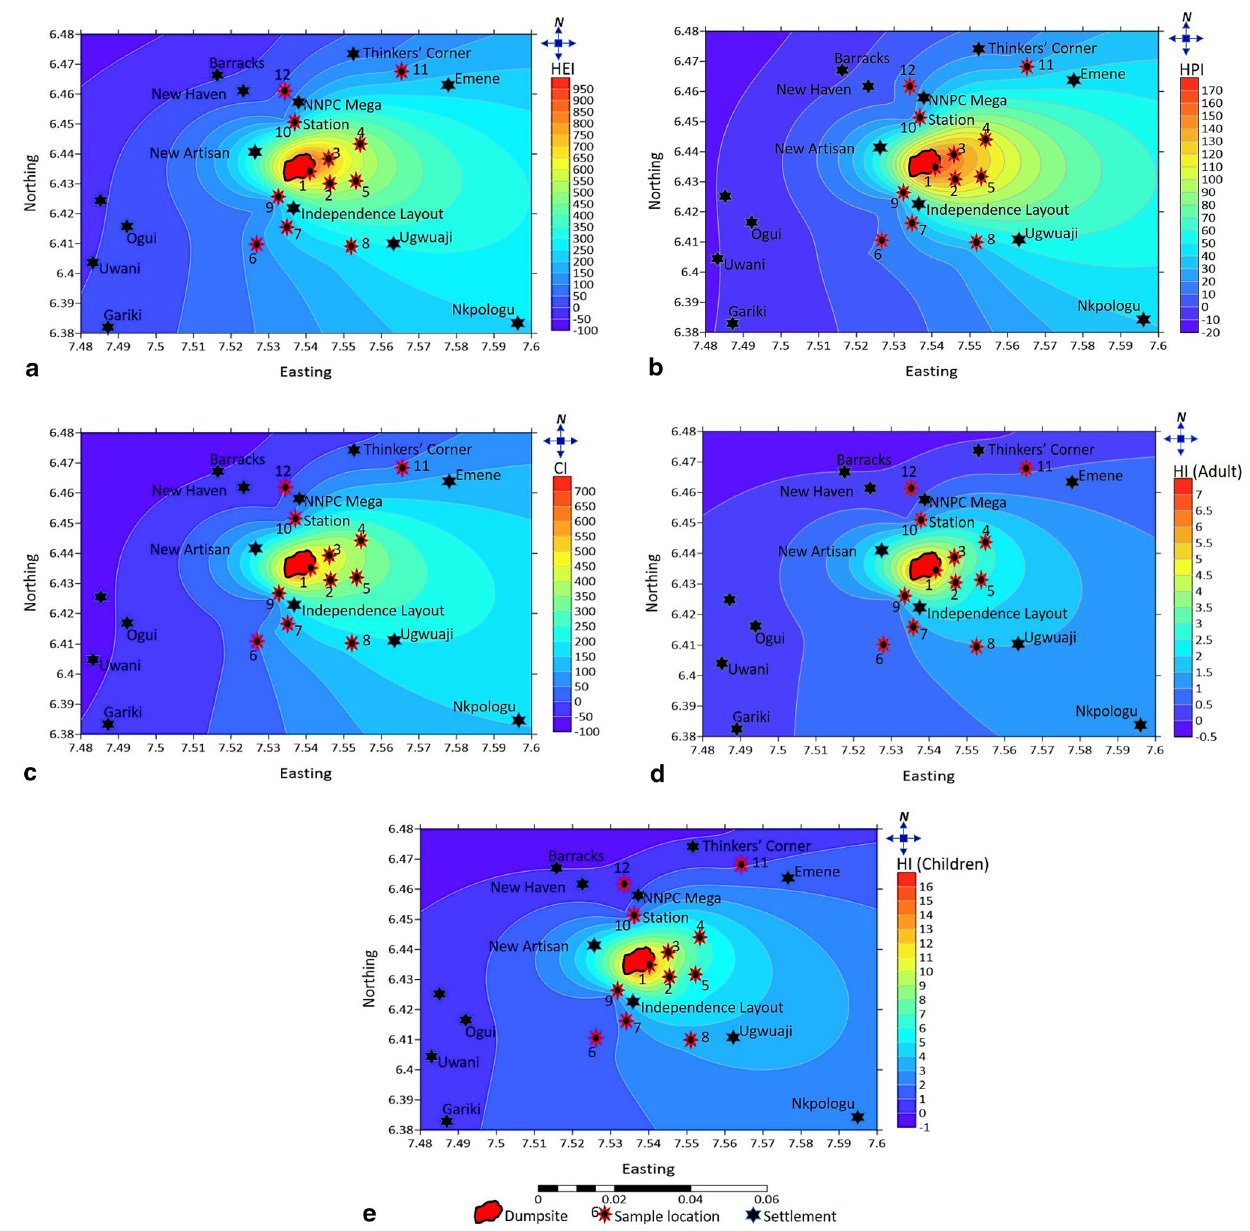
Fig. 15 Contour plots of human health risk indices, a . HEI, b . HPI, c . CI, d . HI (Adult), and e . HI